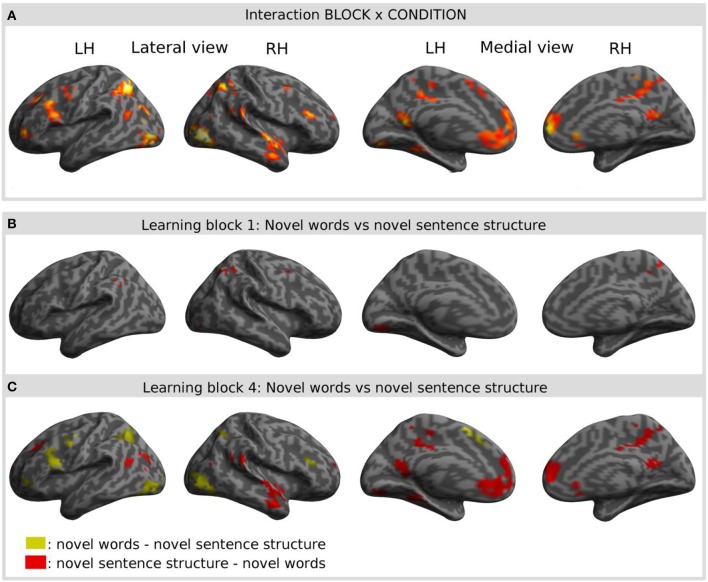
Result of the interaction effect of the 2 × 4 ANOVA with the factors CONDITION and BLOCK and post-hoc t-tests to test simple main effects rendered on an inflated standard MNI cortical surface. (A) Shows the interaction of the factor BLOCK (learning block 1–4) and CONDITION (novel word vs. novel sentence structure). (B,C) Show contrasts between the novel word and the novel sentence structure condition for the first (B) and for the last (C) learning block. Colored areas represent the extent of activations, not statistical values of individual voxels.